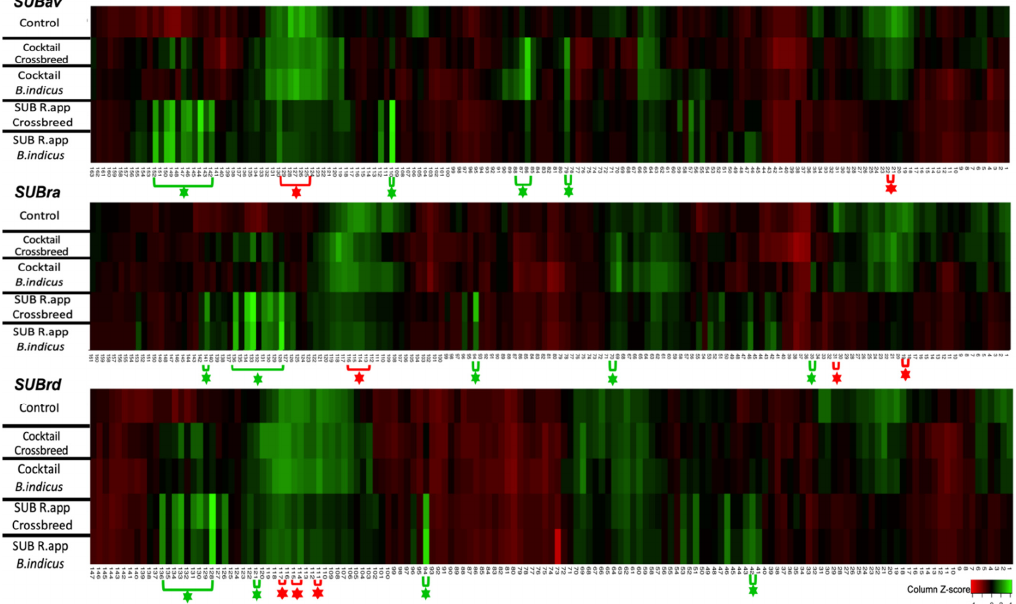
Figure 2. Heatmap of the IgG reactive epitopes in SUBav, SUBra, and SUBrd. Reactivity against peptides is indicated with Z-score, and possible epitope regions were identified with a green asterisk when the Z-score > 2. Red asterisks show peptide regions with significant reactivity with pooled sera from the control